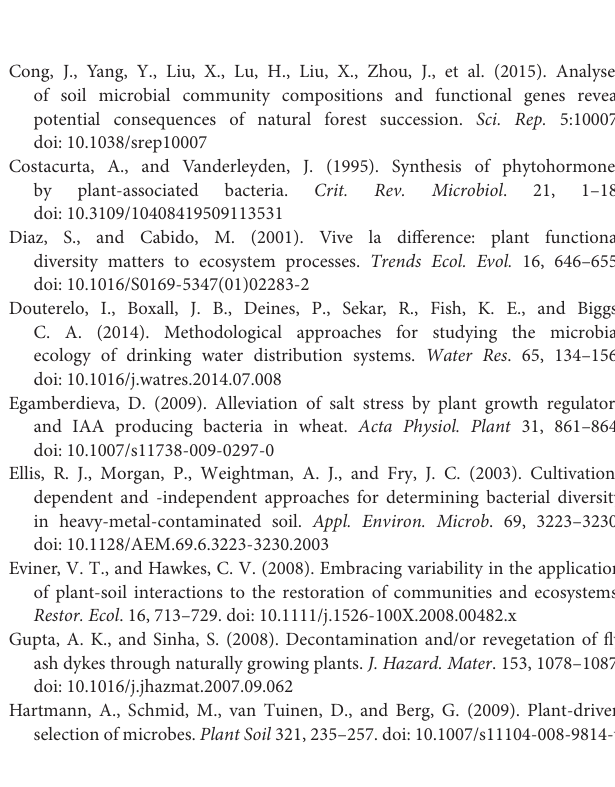
Figure S1 | Effect of Rhizosphere (rhizosphere vs. non-rhizosphere or bulk) and plant species ( S. ravennae vs. C. dactylon ) showed significant impact on soil geochemical characteristics. All data are presented as mean ± SE calculated from 3 replicates. The full name of each site is provided in Figure 1 . (Note: “ ∗ ” above the bars : Significant difference ( t -test, p < 0.05) between rhizosphere and non-rhizosphere region; “ ∗ ” between the bars : Significant difference ( t -test, p < 0.05) between S. ravennae vs. C. dactylon ). Figure S2 | Effect of habitat (fly ash dumps vs. garden) and age of the fly ash dump (young vs. old dump) on soil geo-chemical characteristics. All data are presented as mean ± SE calculated from 3 replicates. The full name of each site is provided in Figure 1 . (Note: “ ∗ ” above the bars : Significant difference ( t -test, p < 0.05) between fly ash dumps and experimental garden; “ ∗ ” between the bars : Significant difference ( t -test, p < 0.05) between the young and old fly ash dump). Figure S3 | Effect of rhizosphere (rhizosphere vs non-rhizosphere or bulk) and plant species ( S. ravennae vs C. dactylon ) on trace and essential elements in fly ash/soil. All data are presented as mean ± SE calculated from 3 replicates. The full name of each site is provided in Figure 1 . (Note: “ ∗ ” above the bars : Significant differences ( t -test, p < 0.05) between rhizosphere and non-rhizosphere region; “ ∗ ” between the bars : Significant differences ( t -test, p < 0.05) between S. ravennae vs. C. dactylon ). Figure S4 | Effect of habitat (fly ash dumps vs. garden) and age of the fly ash dump (young vs. old dump) on trace and essential elements in fly ash/soil. All data are presented as mean ± SE calculated from 3 replicates. The full name of each site is provided in Figure 1 . (Note: “ ∗ ” above the bars : Significant difference ( t -test, p < 0.05) between fly ash dumps and experimental garden; “ ∗ ” between the bars : Significant difference ( t -test, p < 0.05) between the young and old fly ash